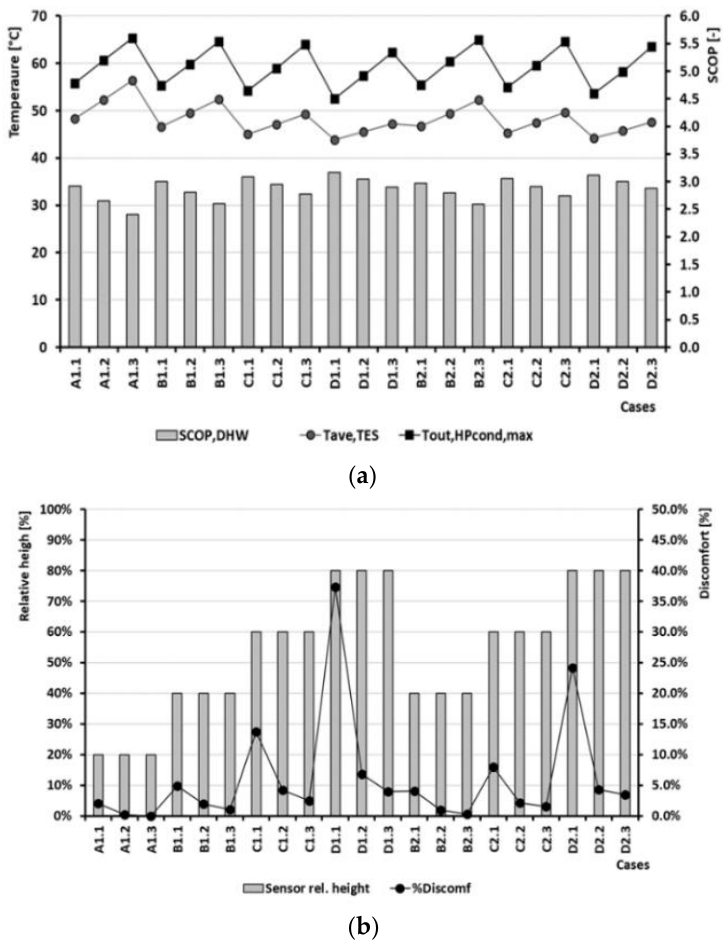
Figure 11. Results of the parametric simulations: ( a ) ETS performance vs. average temperature of the TES and ( b ) relative height of the sensor vs. discomfort percentage.